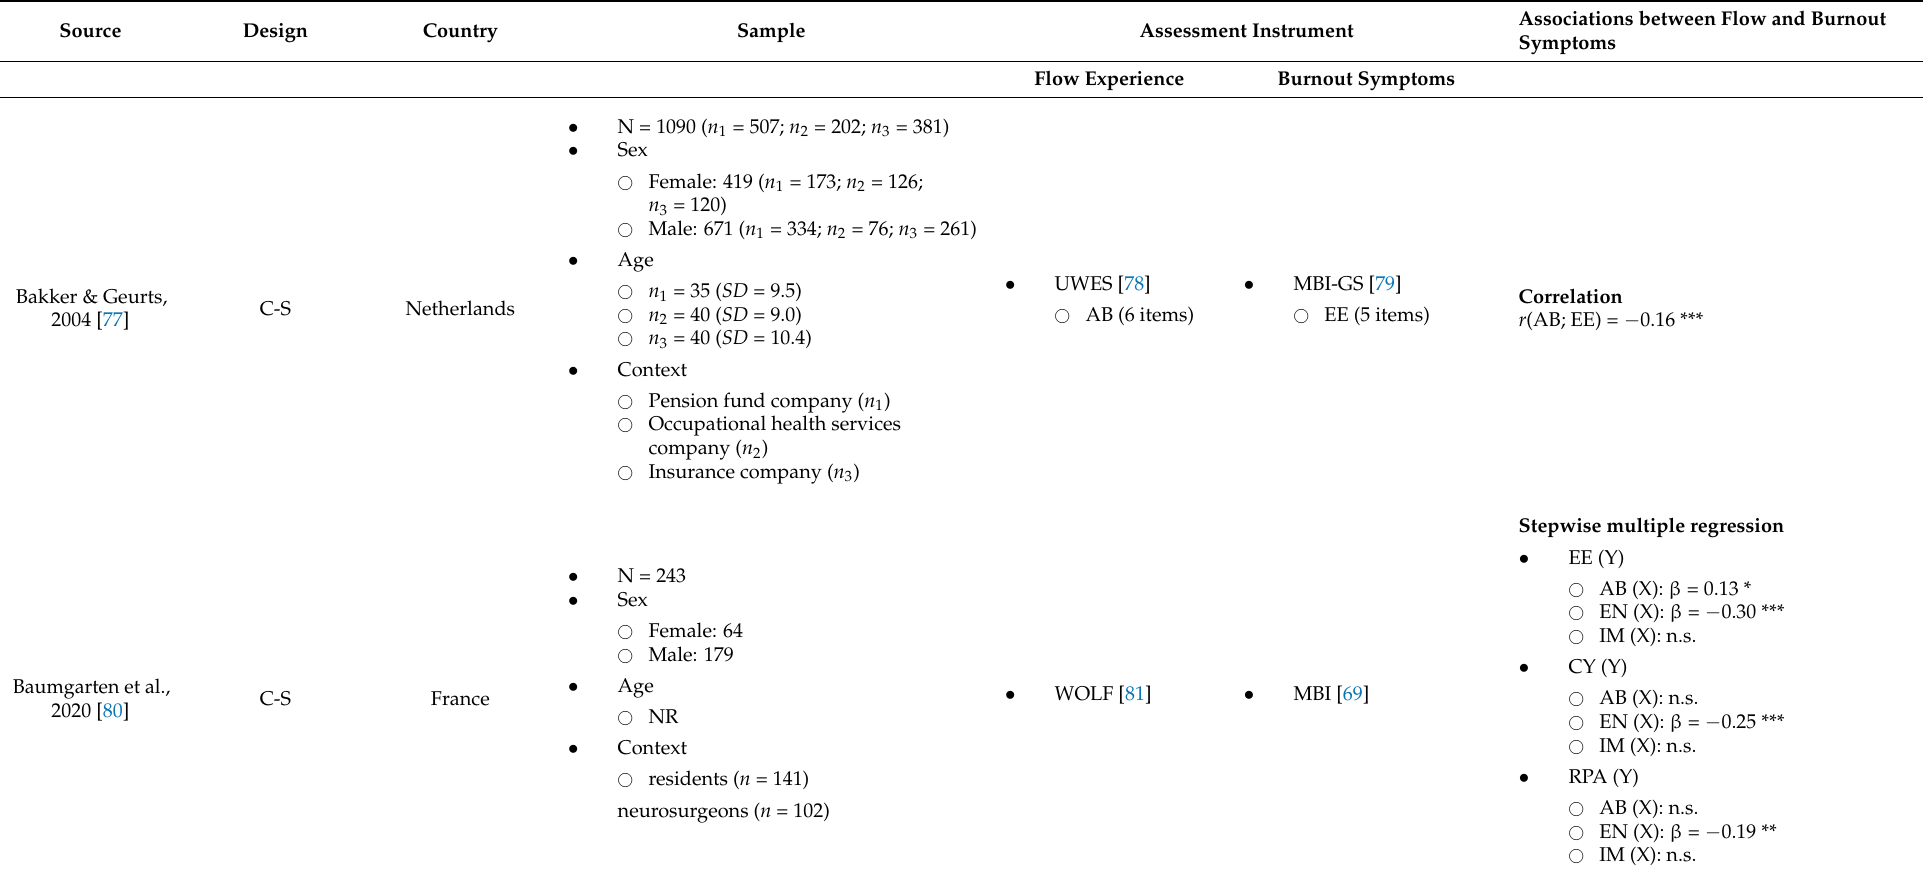
Table 1. Overview of the results of the systematic review regarding design, country, sample, assessment instruments, and associations between flow and burnout